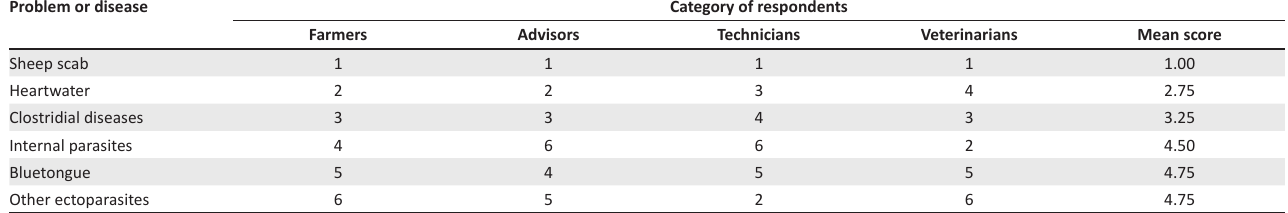
TABLE 6: Summary of responses listing the top six livestock disease problems. Problem or disease